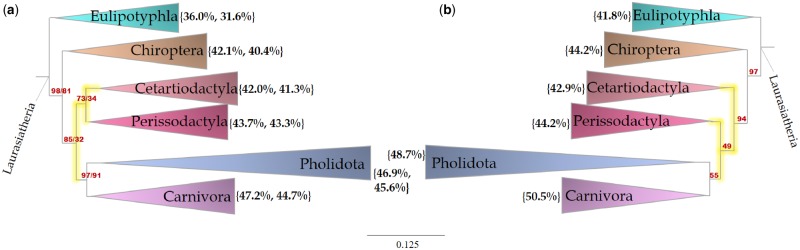
—Maximum-likelihood trees of mammalian relationships based on analysis of Lartillot 2012 data set. (a) The tree inferred from all 51 partitions and from the 29 partitions that passed the MaxSymTest. (b) The tree inferred from 22 partitions that failed the MaxSymTest. Red numbers at the internal branches indicate the bootstrap support values that are <100% under the best fitting model. Numbers in curly brackets show the GC content (in panel a, %GC and bootstrap support values are for Tall and Tpass, respectively).